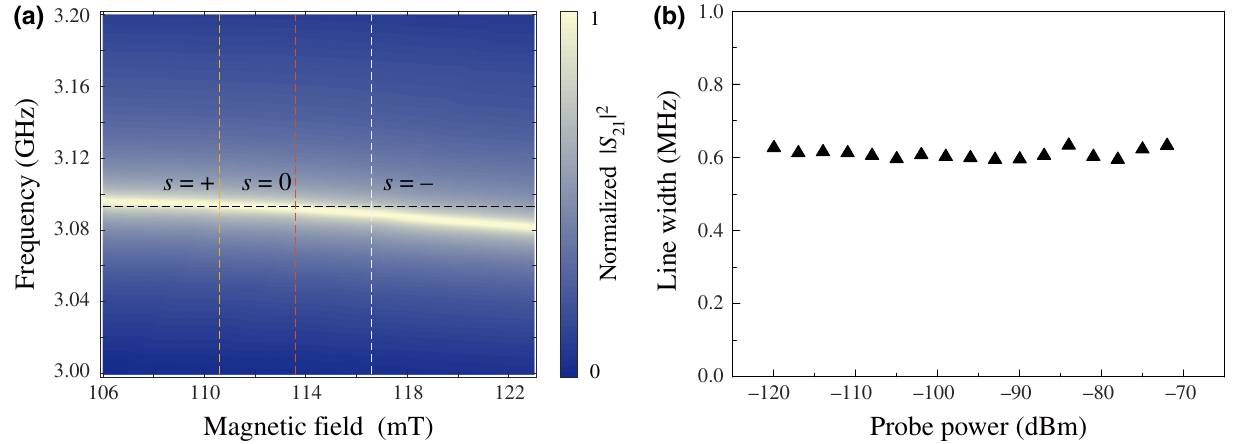
FIG. 8. (a) The dependence of the resonator-mode bare frequency on the static magnetic field. The transmission spectrum is obtained in the same way as in Fig. 2(a), but using a strong probe tone. (b) The measured line width of the resonator mode versus the drive